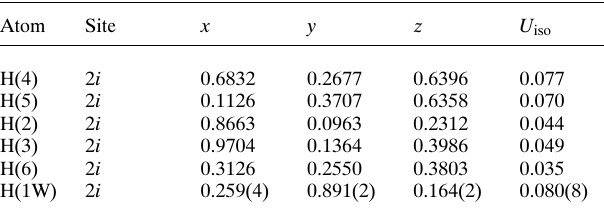
Table 2. Atomic coordinates and displacement parameters (in Å 2 )